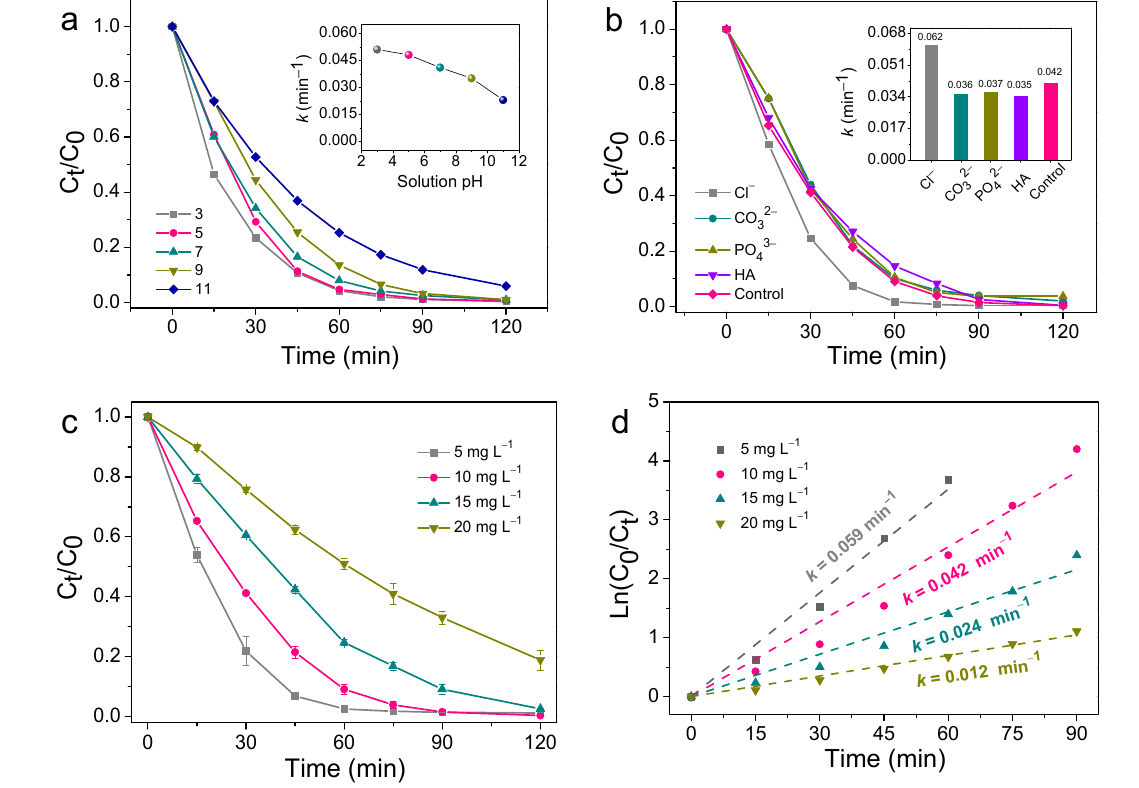
Figure 6. Effects of ( a ) solution pH and ( b ) background species, and ( c , d ) initial SMT concentration on unbiased TiO 2 NNs-Co 3 O 4 PEC system for removal of SMT.